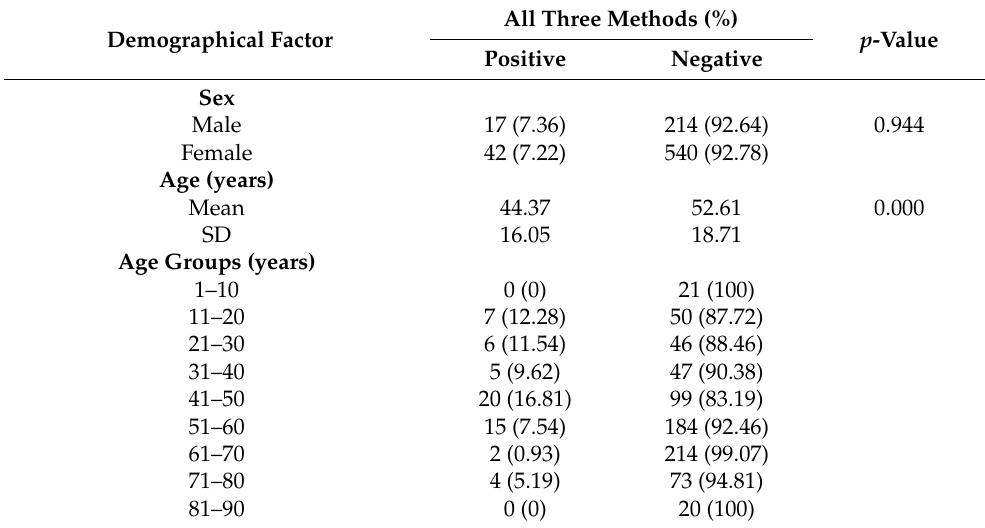
Table 2. Life history and EBV status (%).